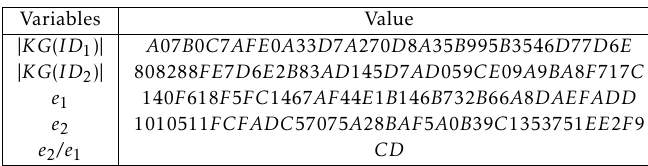
Table 1. Example of an attack on the ID-MRSA in real world